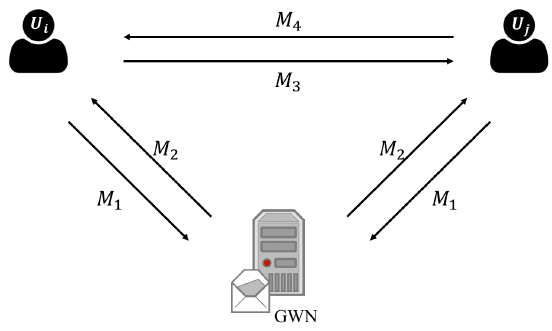
Figure 4. The message delivery structure in the authentication process of